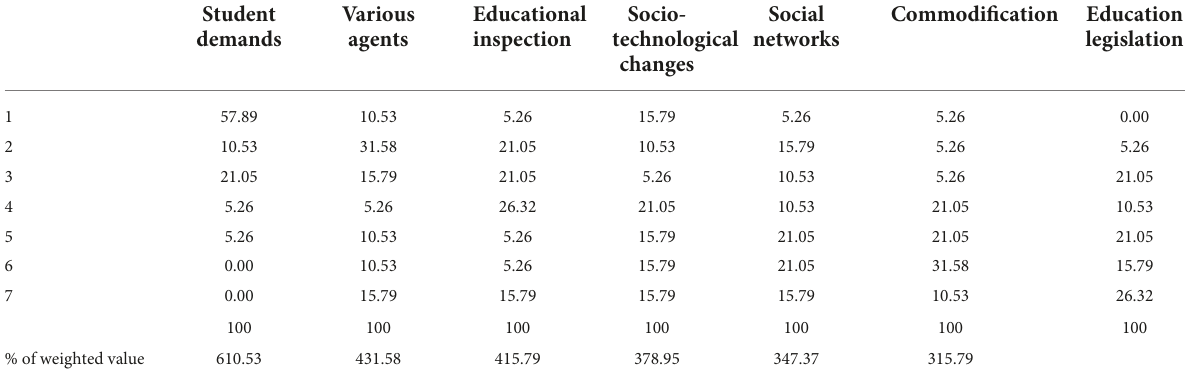
TABLE 13 Opinions on the promotion of educational innovation, from highest to lowest priority.